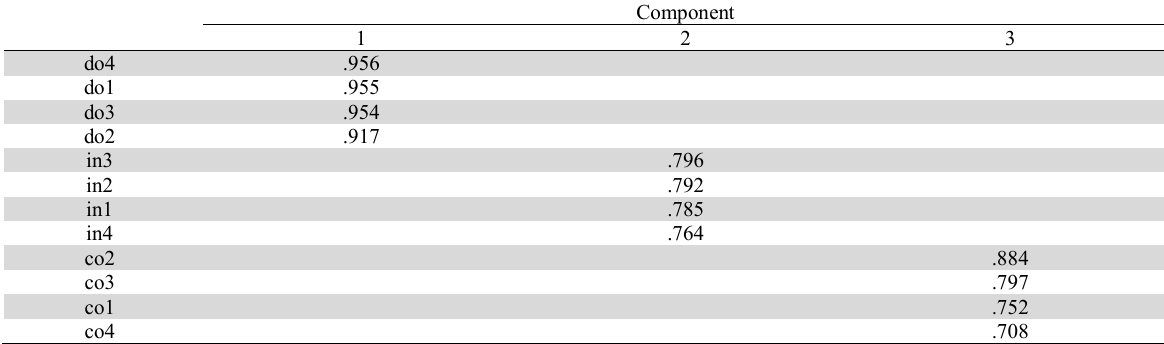
Rotated Component Matrix